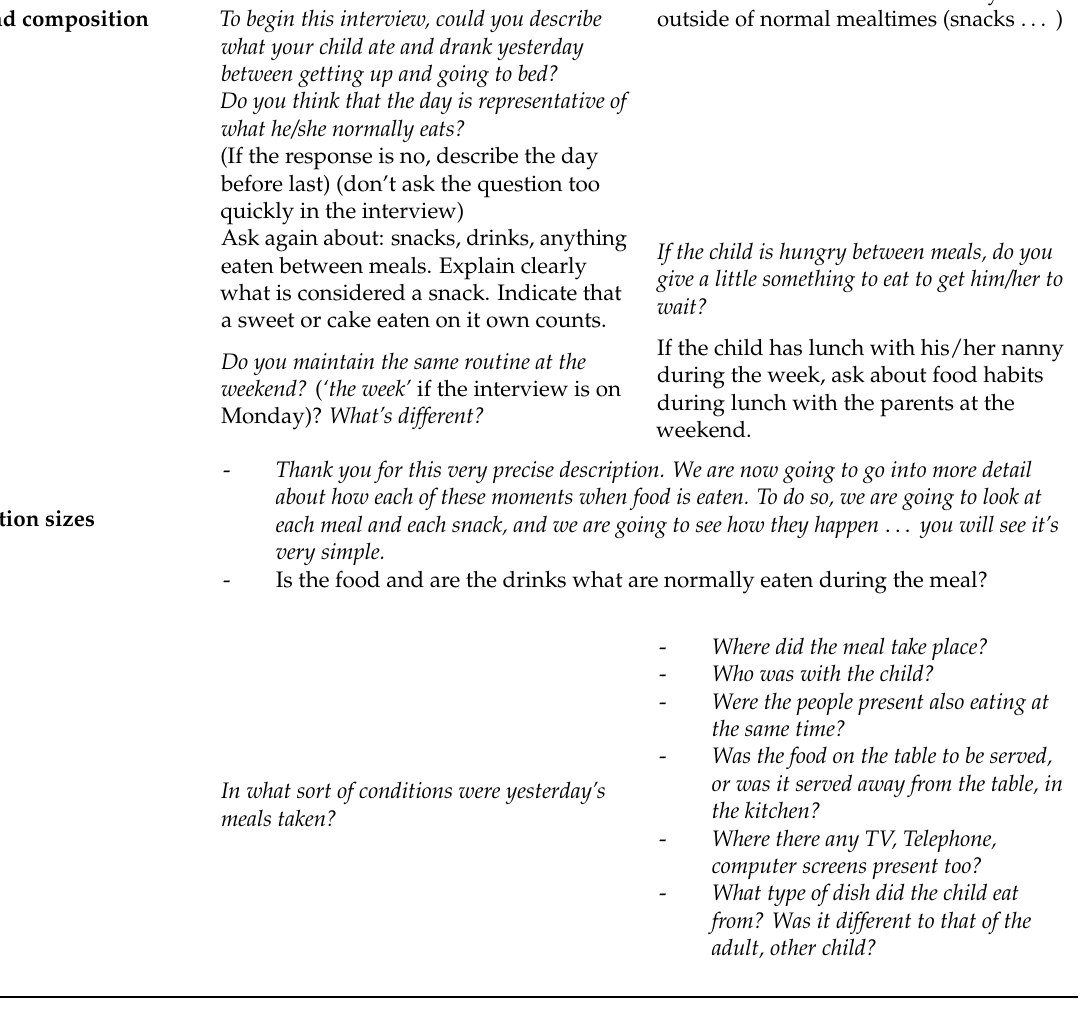
Meal organization and